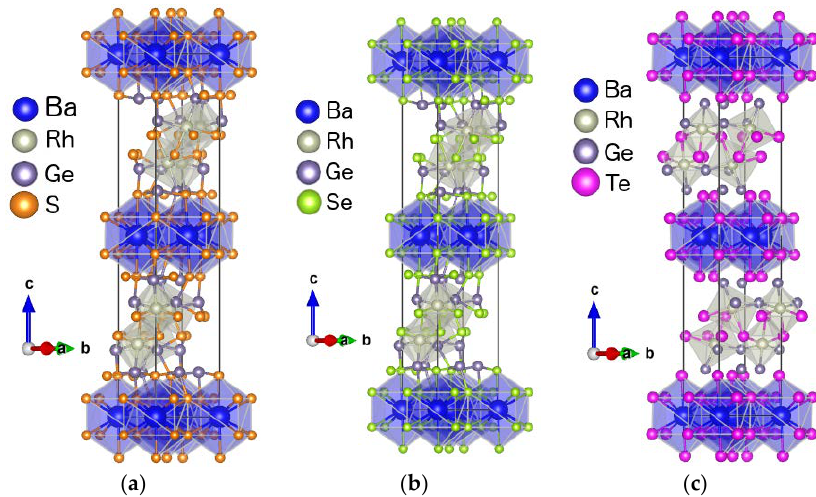
Figure 1. Structures of the BaRh 2 Ge 4 S 6 ( a ), BaRh 2 Ge 4 Se 6 ( b ) and BaRh 2 Ge 4 Te 6 ( c ) compounds. Barium atoms are big balls in blue, rhodium in grey, germanium in purple, sulphur in orange, selenium atoms are small balls in green and Te in magenta.